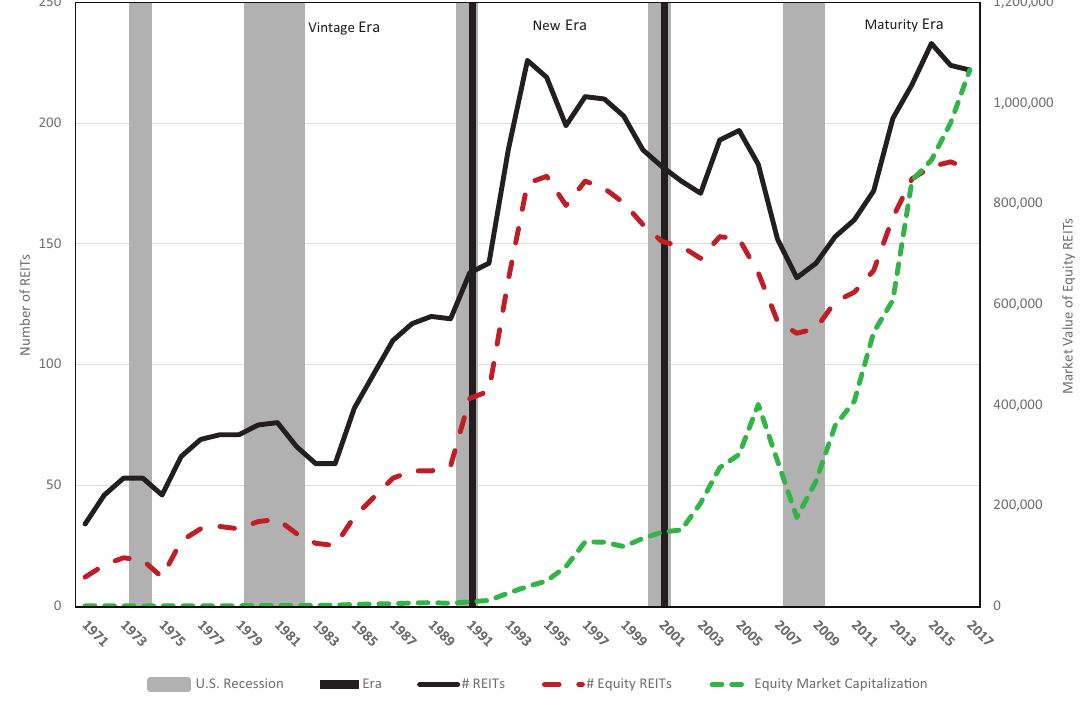
Panel A: Annual number and annual total market value of REITs as covered in the